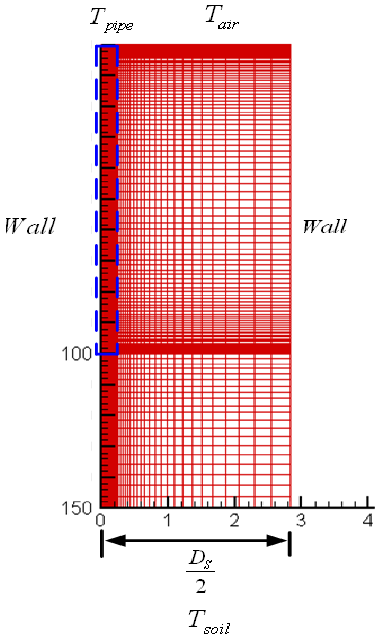
Figure 4. Transformation of a square domain to an equivalent concentric